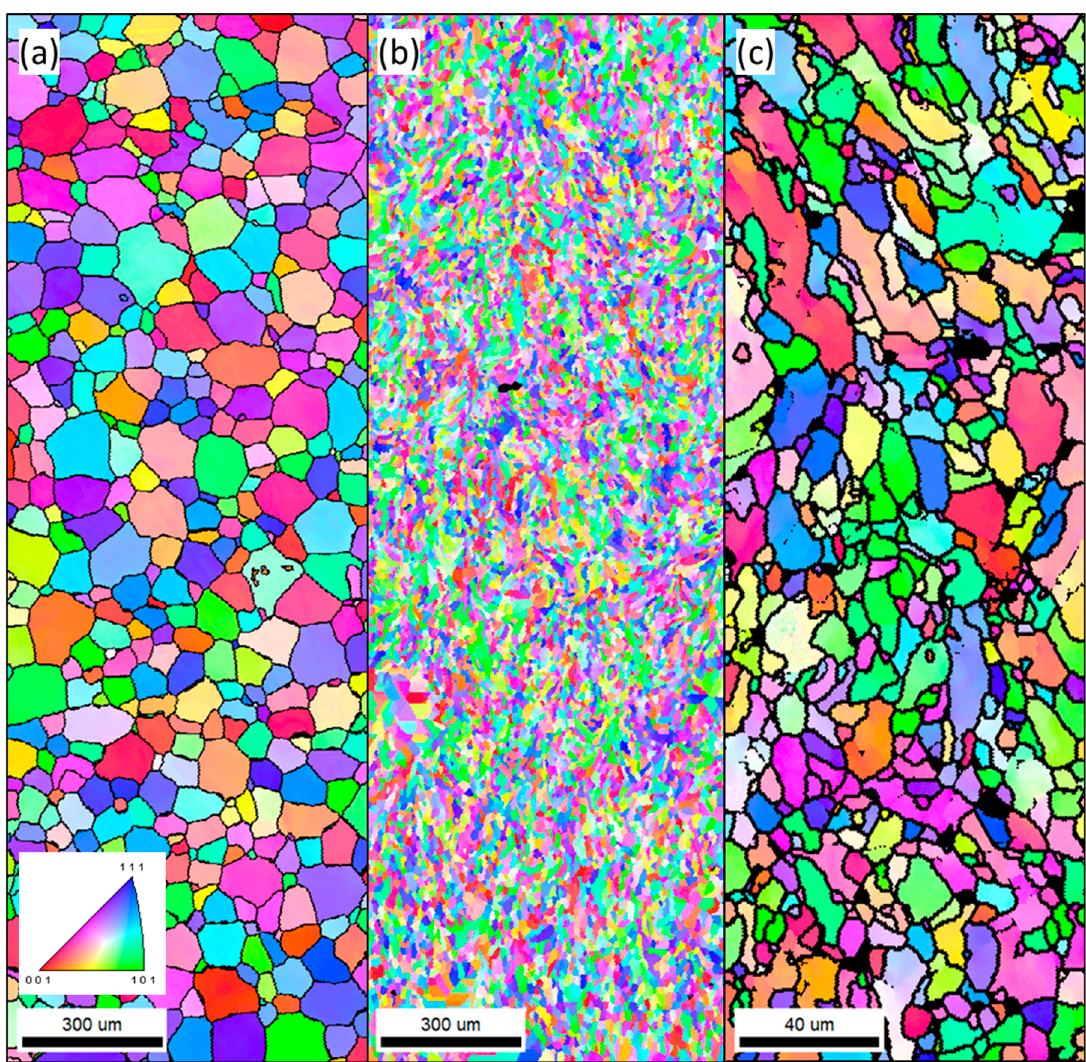
Figure 3. Electron back scatter diffraction (EBSD) crystal orientation images for ordered wrought material ( a ) and ordered AM material ( b , c ).